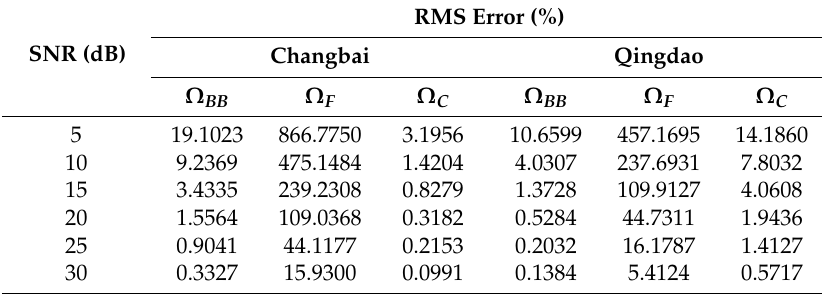
Table 1. RMS error ( σ RMS ) under the condition of system noise.